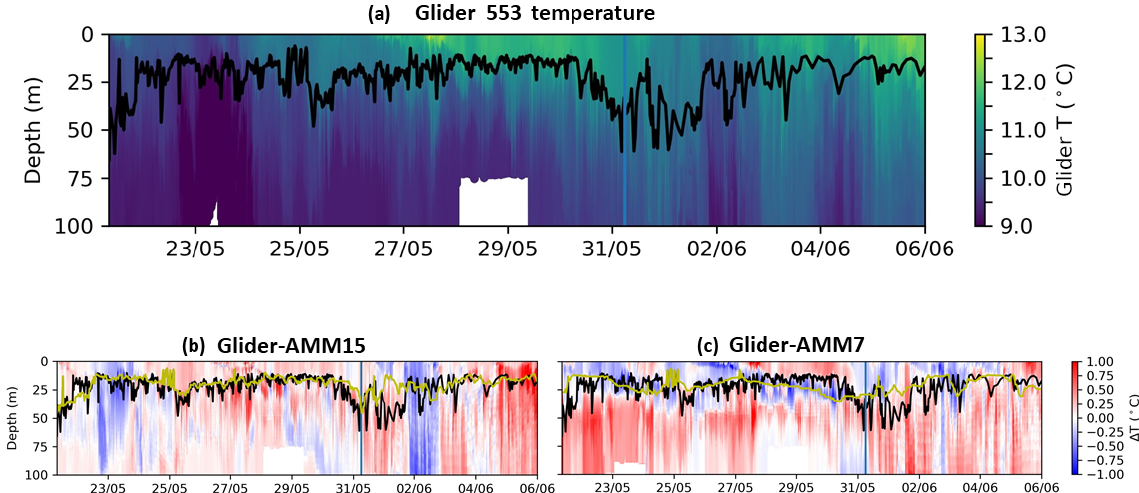
Figure 15. Top 100m of temperature profile along glider 553-100 trajectory. (a) Temperature measured by the glider. (b) Difference between the glider and AMM15. (c) Difference between the glider and AMM7. The vertical blue line represents time when the glider goes over the shelf break, crossing the 200m isobath. Before that time, the glider is on the shelf. The black line is the MLD computed from the glider measurements; the yellow line is the model MLD.